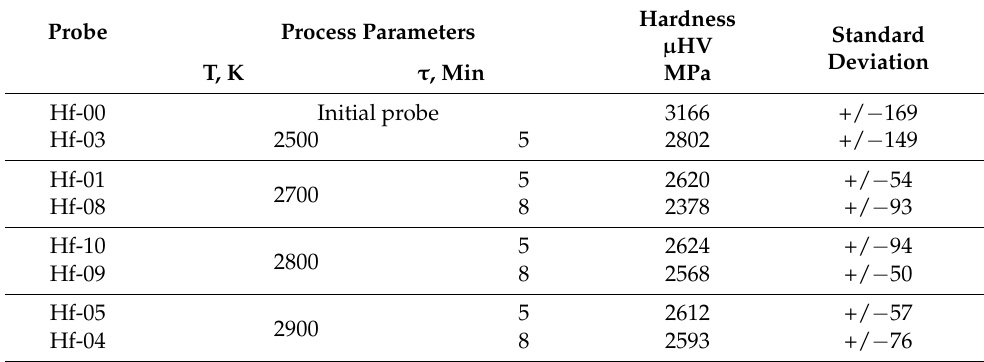
Table 4. Average micro-hardness and standard deviation measured for hafnium specimens produced under different technological modes after single EBMR.